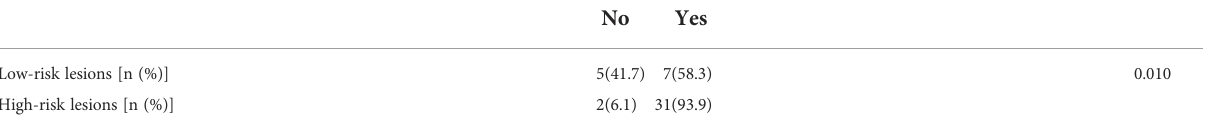
TABLE 3 Localized colonic wall thickening shown by 18 F-FDG PET/CT ( n =45).